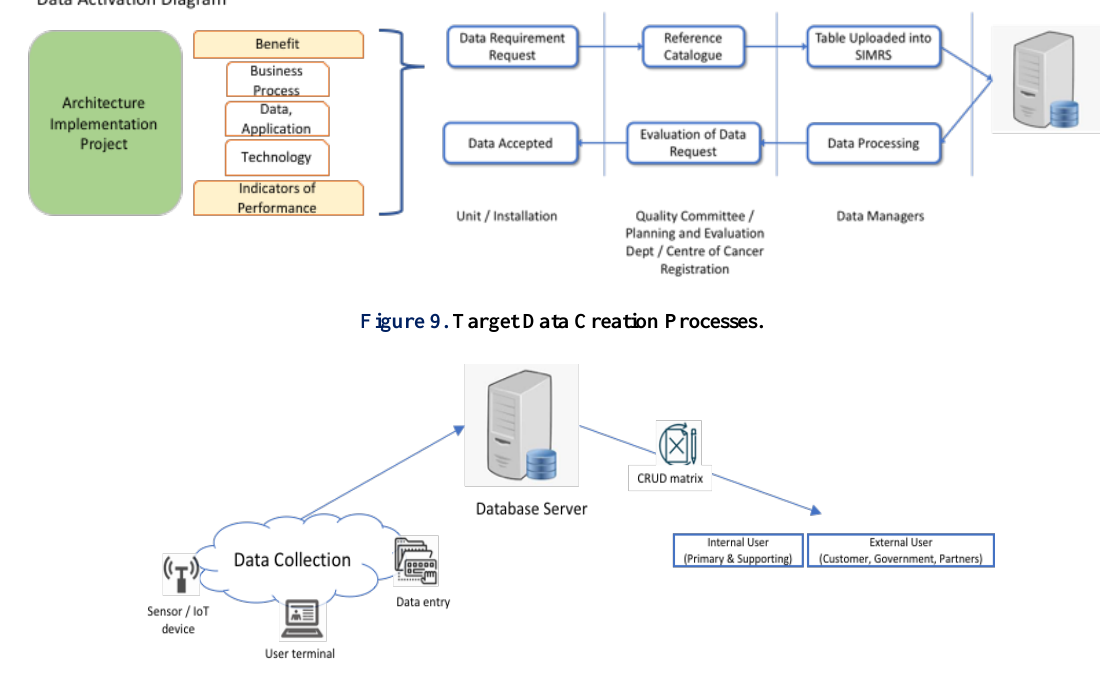
Figure 10. Target Data Operationalization